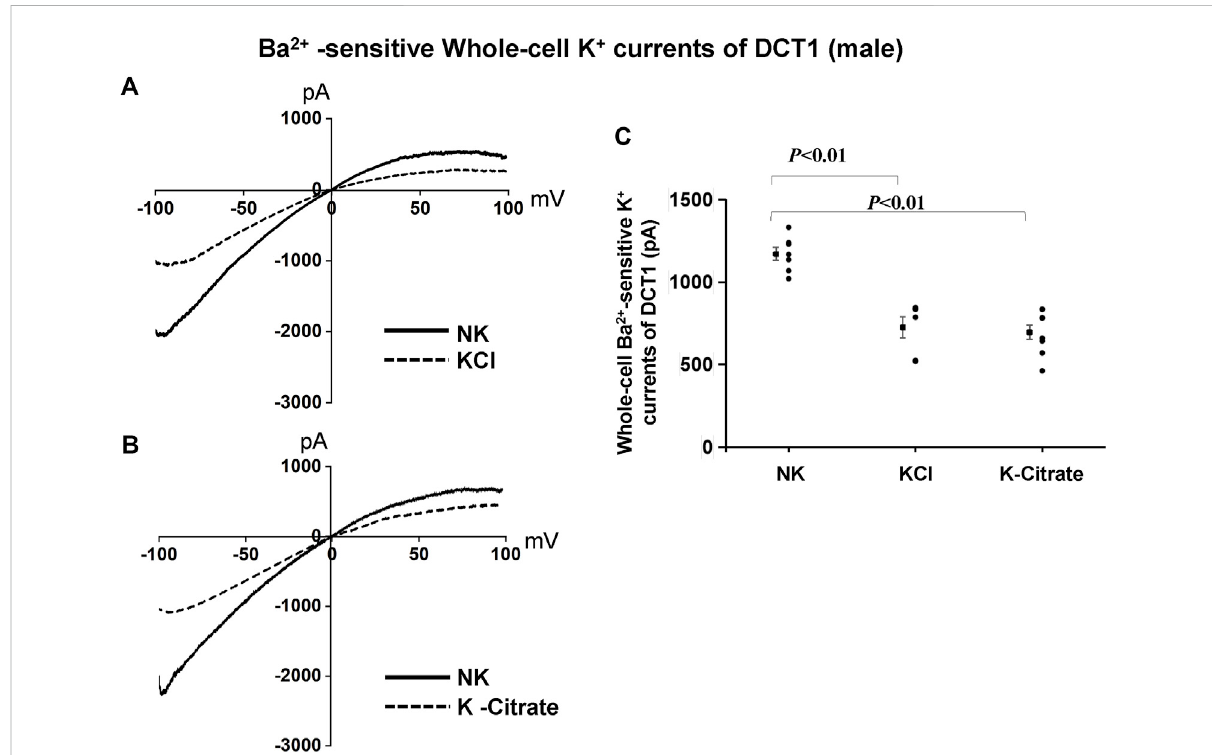
FIGURE 2 Cl − content of HK diets does not affect HK-induced inhibition of Kir4.1/Kir5.1 currents of the DCT of male mice. A set of whole-cell recordings shows Ba 2+ (0.1 mM)-sensitive Kir4.1/Kir5.1-mediated K + currents in the DCT of male mice on NK or 5% K-Cl diet for 7 days (A) and on NK and K-citratefor7 days (B) .Thewhole-cellK + currentsweremeasuredwithrampprotocolfrom-100to100 mVusingsymmetrical140 mMKClsolution in the bath and pipette. (C) A scatter graph summarizes the results of K + currents measured at – 60 mV in the DCT of male mice on different K + diets. The mean value and SEM are shown on the left of each